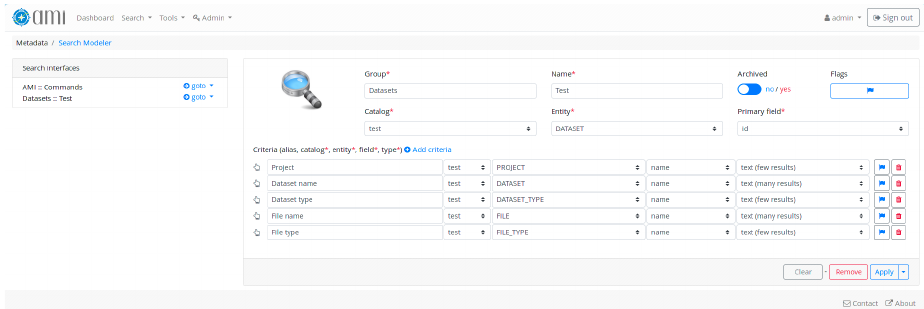
Fig 4. Screenshot of the AMI Search Modeler. Example of interface definition for searching “Datasets” (see associated database schema Figure 3) by “Project”, “Dataset name”, “Dataset type”, “File name” and “File